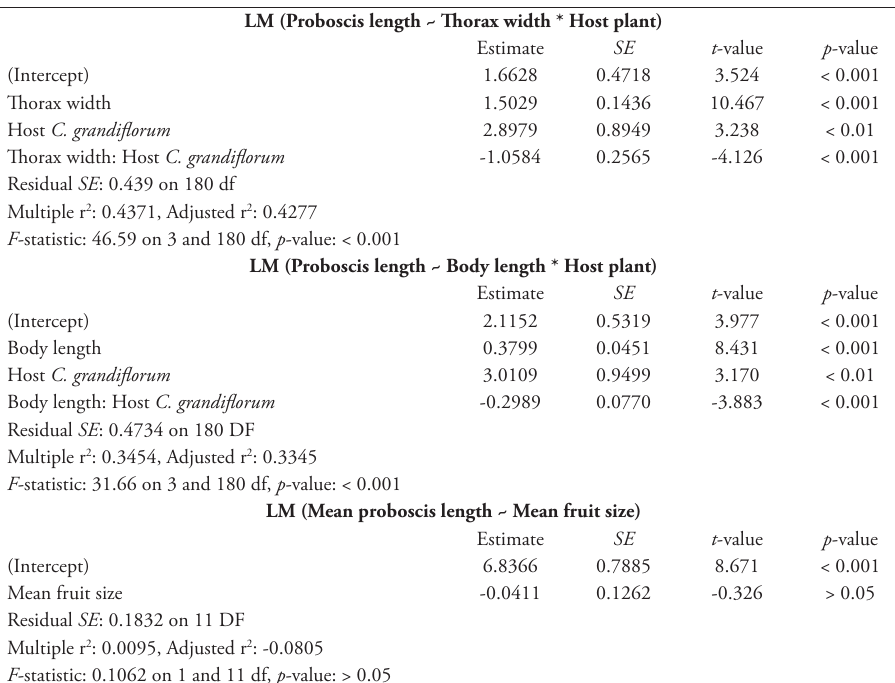
Table 1. Details of the models used to quantify and compare allometries of soapberry bugs in KNP, and to assess the relationship between population means of halicacabum bug proboscis length (in mm) and C. halicacabum fruit size (in